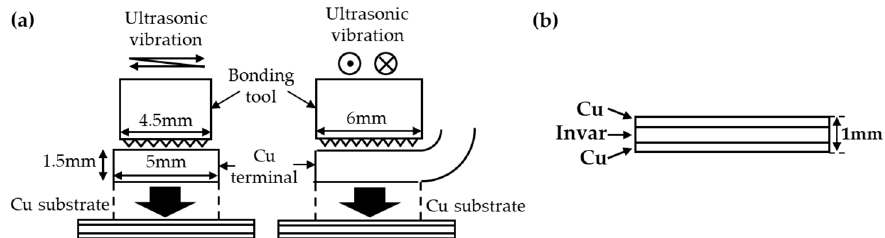
Figure 1. Schematic illustration of the specimen used for the ultrasonic bonding process. ( a ) The size of the bonding tool and copper terminal. ( b ) A clad material composed of copper/invar/copper used for the bonding substrate.